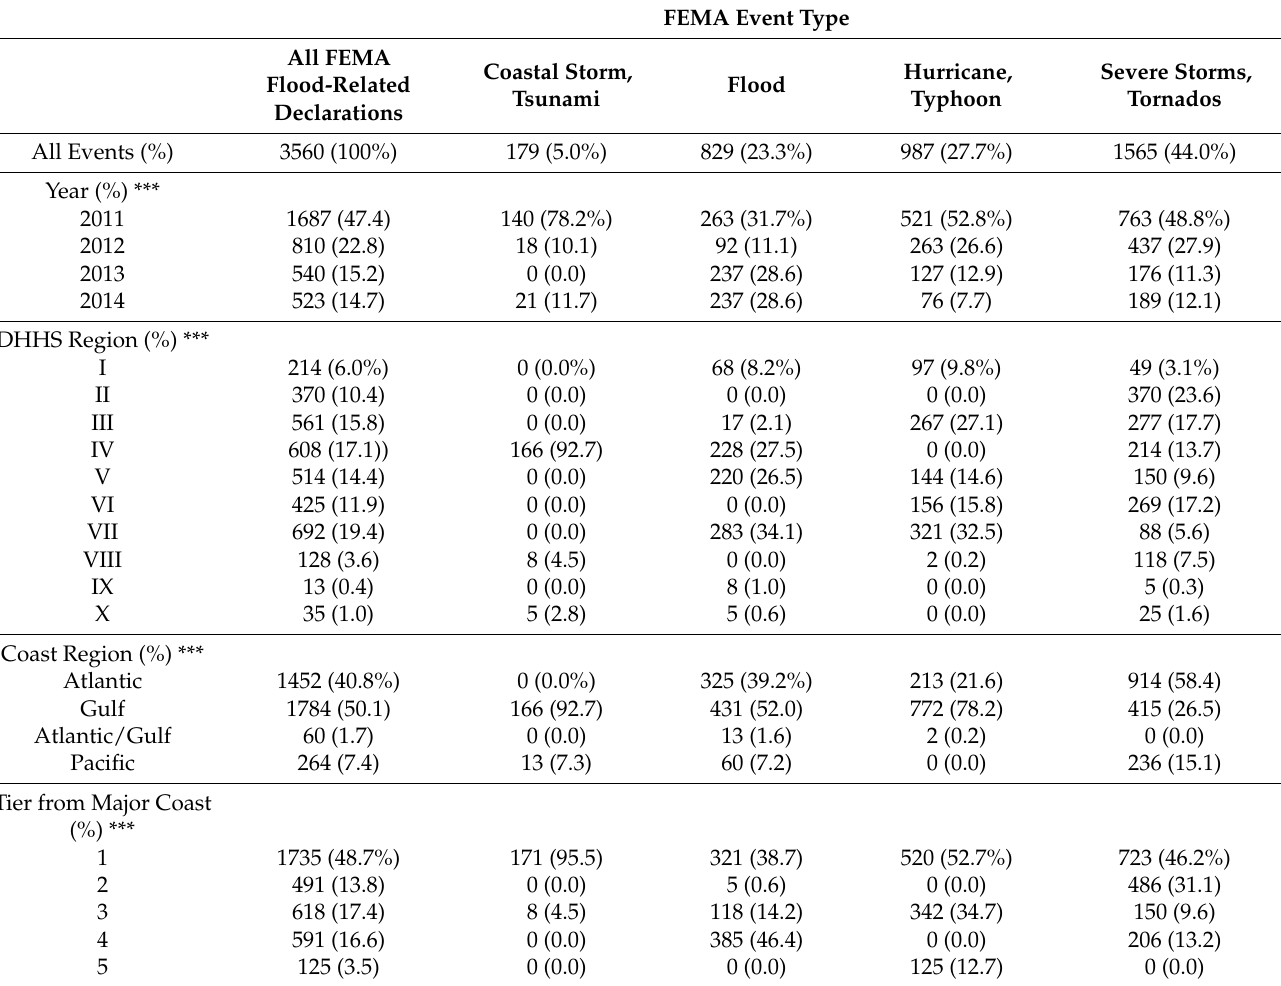
Table 1. Distribution of FEMA event type by year, FEMA region, coast region, tier from major coast, length of disaster and average county population size, by county,